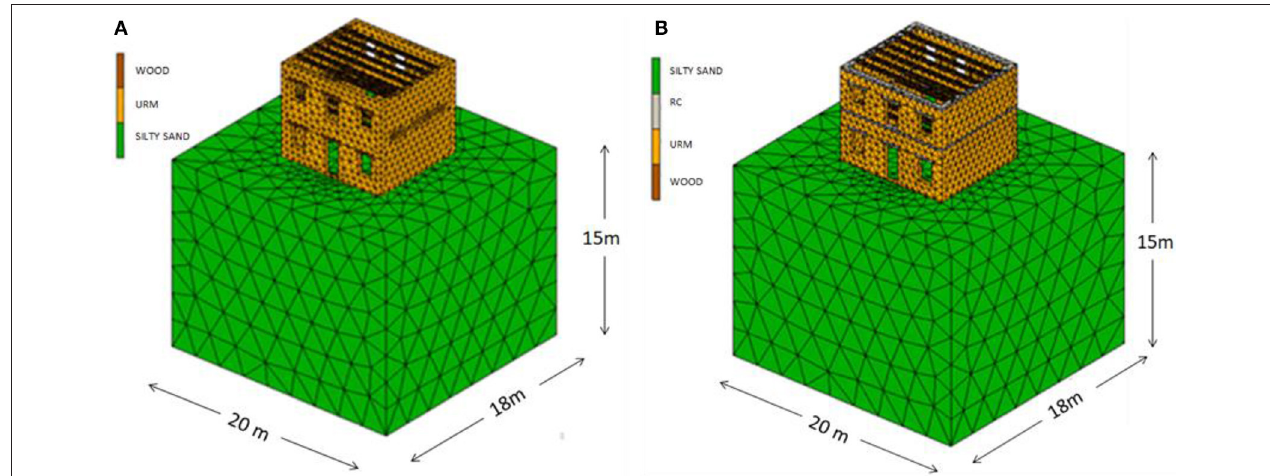
FIGURE 4 | The finite element models for: (A) the building in its initial state and (B) the slightly retrofitted masonry building.